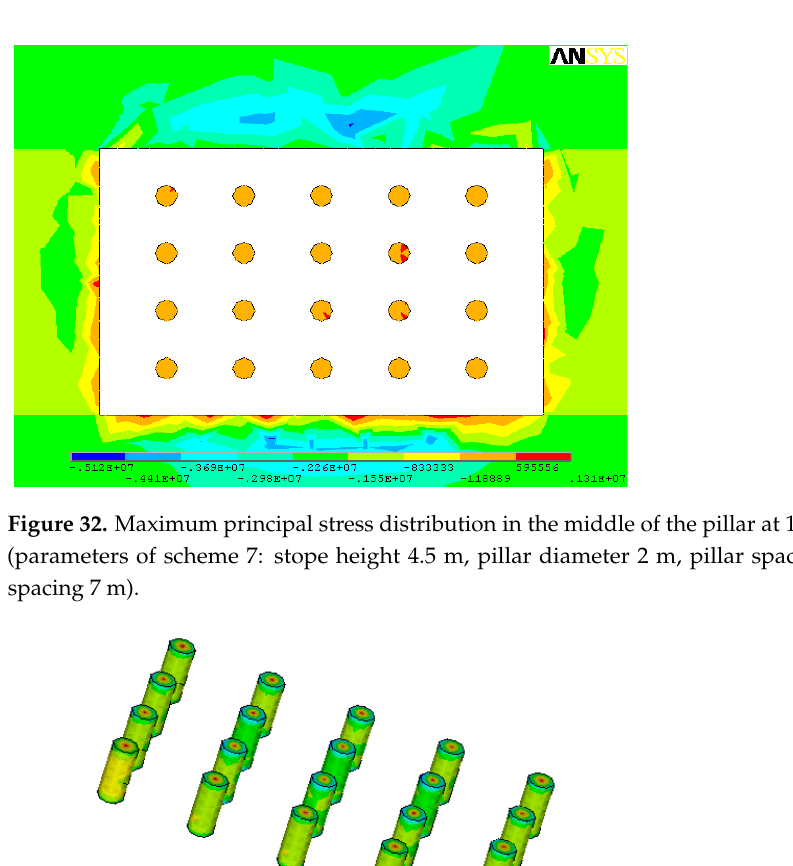
Figure 31. Maximum principal stress distribution of scheme 7 pillars at 1480 mL (parameters of